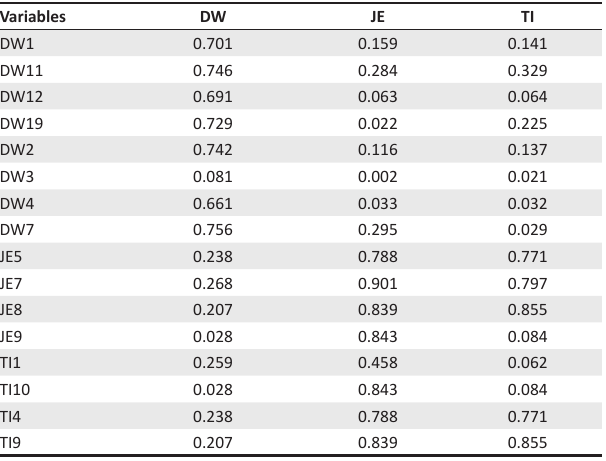
TABLE 2: Cross-loadings and factor loadings of